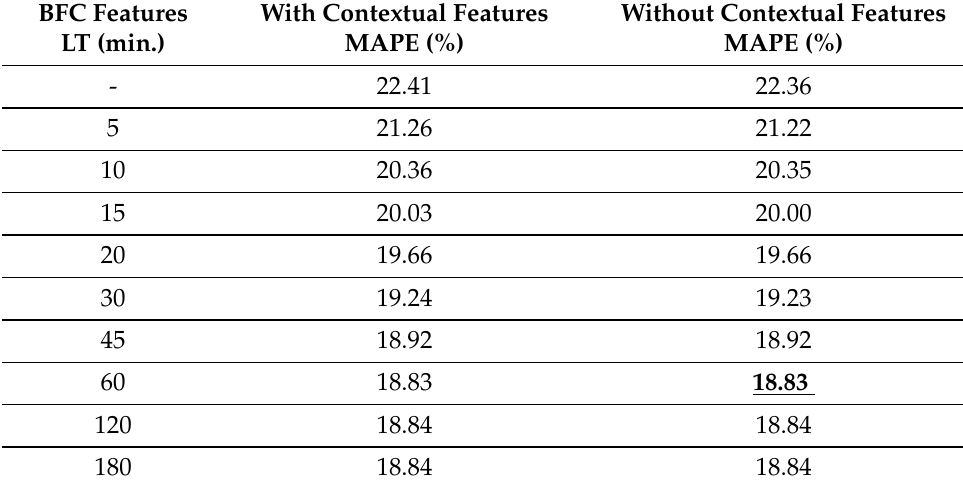
Table 6. Performance comparison between Multi-Linear Regression models.